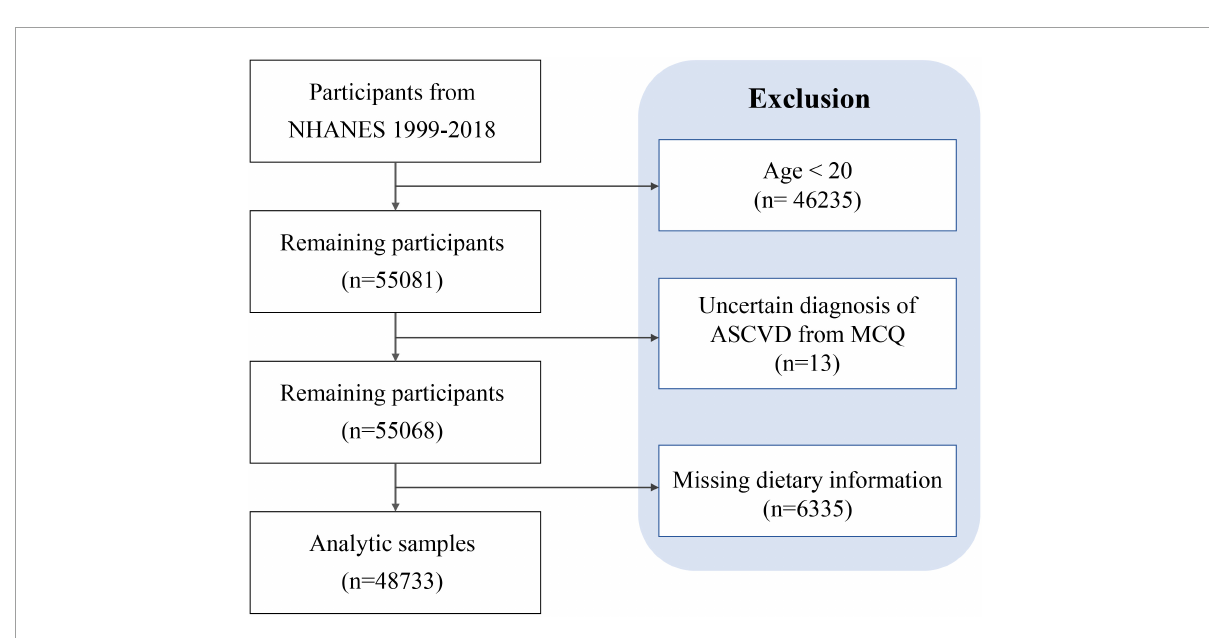
FIGURE1 Flow chart of study